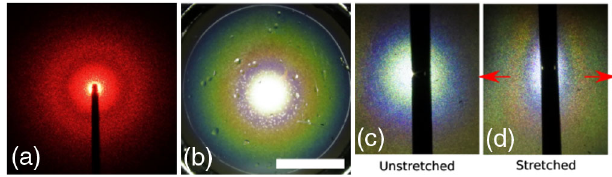
FIG. 4. Optical properties of self-assembled composites of uniform fluorinated-oil droplets in a silicone-gel matrix. (a) The light-scattering pattern of a helium-neon laser by a sample ( E ¼ 837 kPa silicone gel saturated with fluorinated oil at 40 °C and cooled at 30 °C/ min) has a clear ring, indicating droplet uniformity. The center of the dark ring is at a scattering angle of 6.5°. The vertical, dark line is a beam stop. (b) Different wave- lengths of light are scattered to different angles, leading to colorful rings when a sample (Sylgard 184, E ¼ 40 kPa, cooled from 42 °C at 6 °C/ min) is illuminated from behind with a white- light LED. The scale bar is 10 mm long. (c,d) The color pattern is deformed upon stretching (Sylgard 184, E ¼ 412 kPa, cooled from 42 °C at 6 °C/ min). Here, the direct light from the white- light LED source is blocked by a 2-mm-thick rod to better visualize the colors. See Video 2 in Ref.